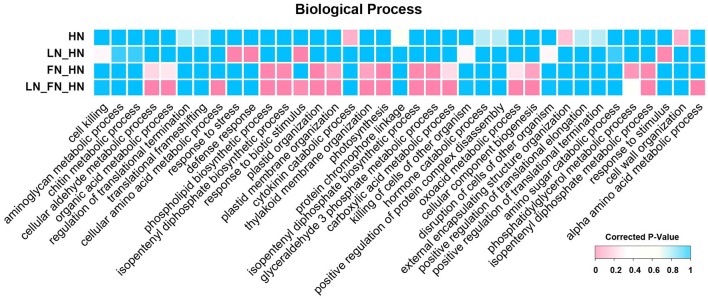
Cross-comparison of functional enrichment analysis of DEGs in response to N stress. Different colors in the block represent the different significance levels of the overrepresentation.